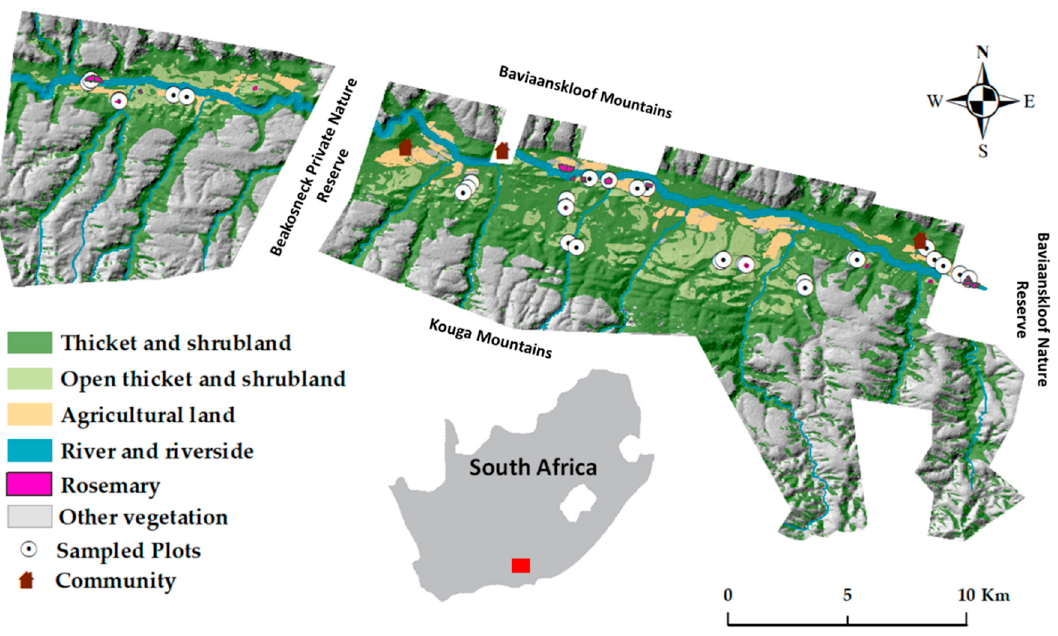
Figure 1. Study area in the Baviaanskloof Hartland Bawarea Conservancy in South Africa. The shading illustrates the terrain